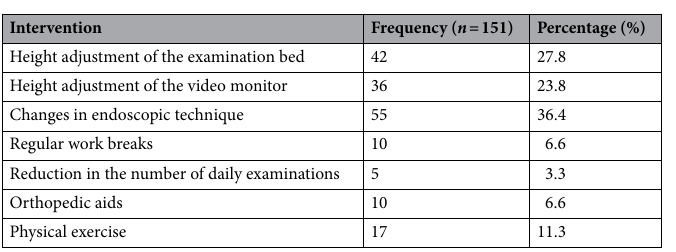
Table 4. Changes at work in response to endoscopy-associated musculoskeletal